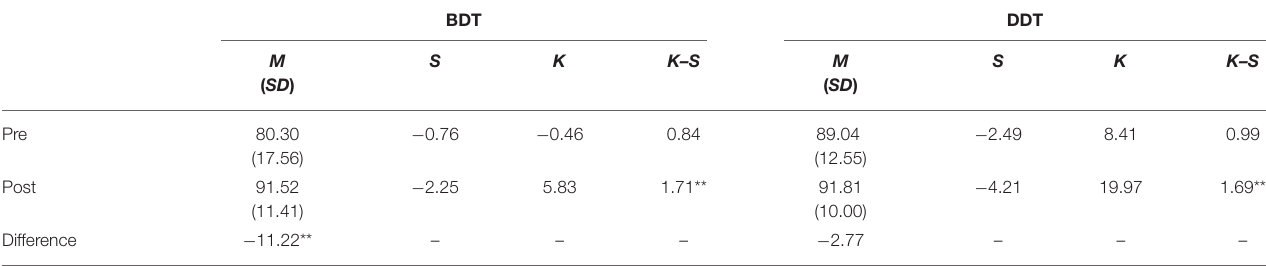
TABLE 5 | Accuracy (%) in BDT and DDT before and after the mindfulness training in elite shooting athletes of the national team ( n = 27).